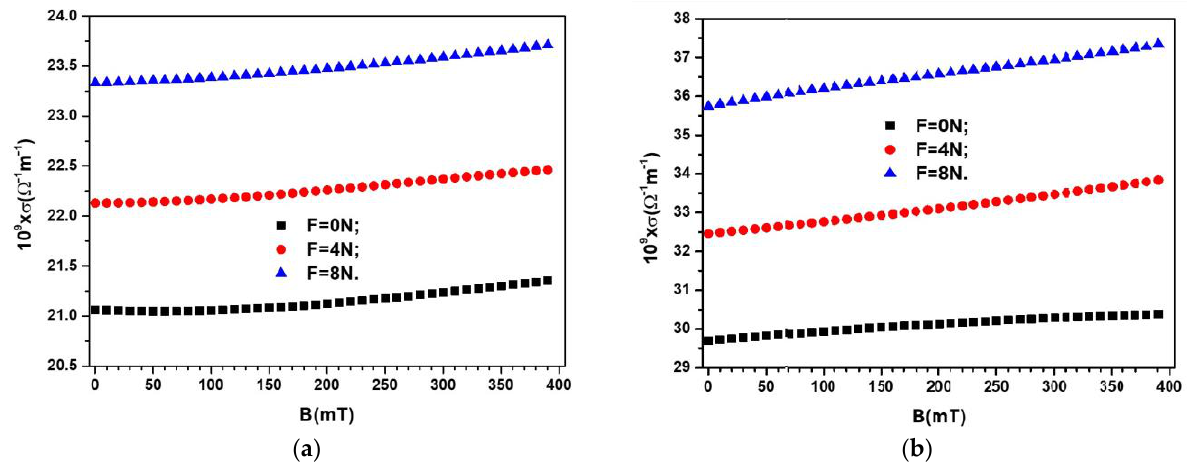
Figure 11. Electrical conductivity σ of the devices ED as a function of values B of the magnetic flux density superimposed on the electric field with the frequency f = 1 kHz, and values F of the force as a parameter. ( a ) MC 1 . ( b ) MC 2 .